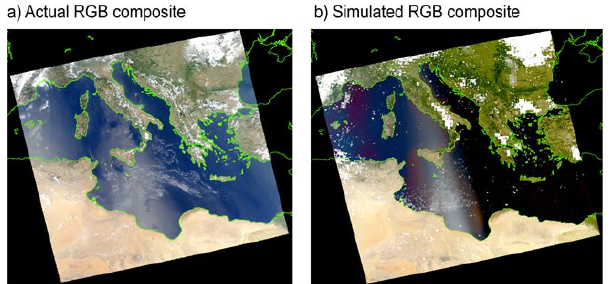
Fig. 1. Synthetic sensor radiance simulation together with an actual MODIS granule that was used as study area. Aqua MODIS granule 2012 day 228 at 12:00UTC. GEOS-5 temporal fit between 12:00 and 18:00UTC, 15 August 2012. RGB (0.67µm, 0.55µm, 0.47µm).